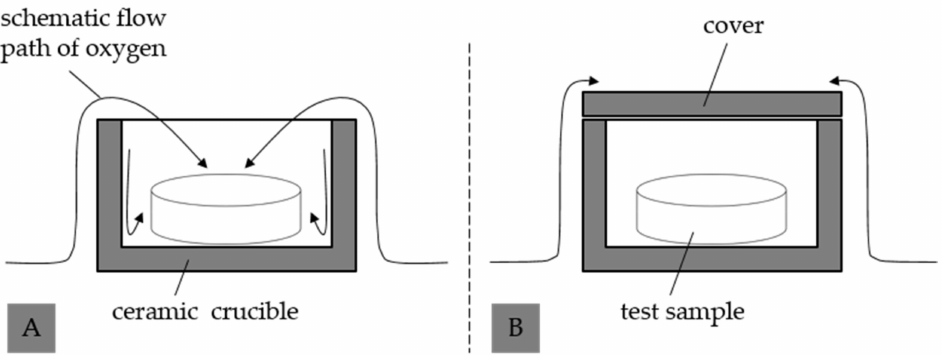
Figure 4. Schematic flow path of oxygen and interference with the test sample during the thermal recycling strategy without ( A ) and with ( B )